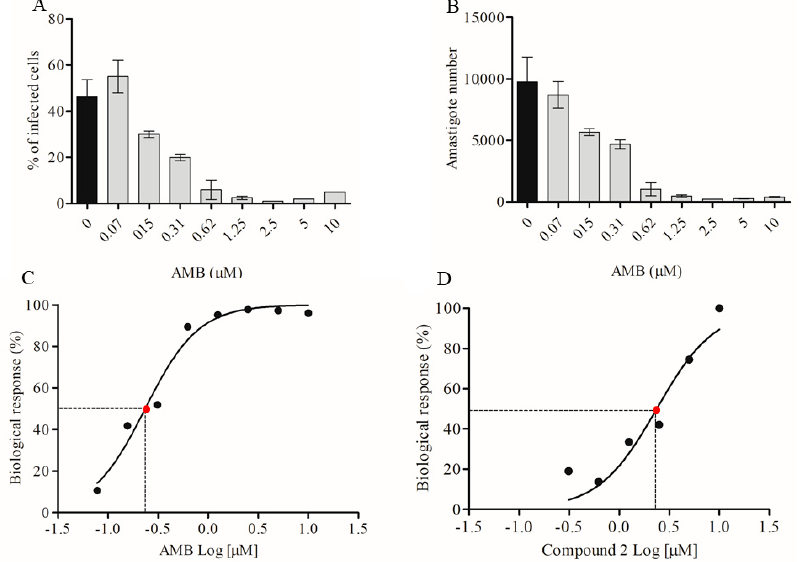
Figure 5. Automated quantification of amastigotes after treatment. ( A , B ) Infected cells were treated with AMB at different concentrations. The automated image segmentation and parasites quantification workflow were applied to determine the percentage of infection as well as the number of amastigotes. Bars represent the mean ± SD of one representative assay performed with eight replicates. ( C , D ) Quantification of the biological response after the treatment with AMB and compound 2 at concentration ranging from 0.15 to 10 µ M. The correlation coefficient (r2) is 0.97 for AMB and 0.65 for compound 2 . Red dot means the logarithmic concentration related to 50% biologic response.